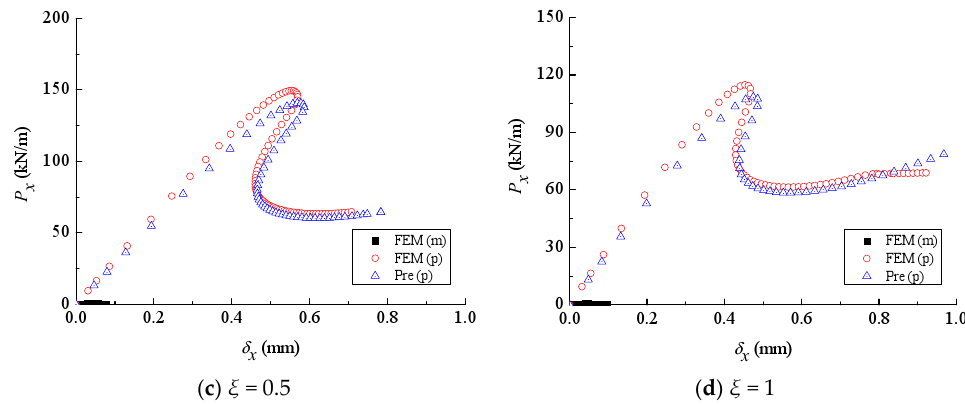
Figure 18. Comparison of the predicted and original load vs. end-shortening curves of the stringer- stiffened cylinders with the SS3 boundary condition when the model material is PVC.